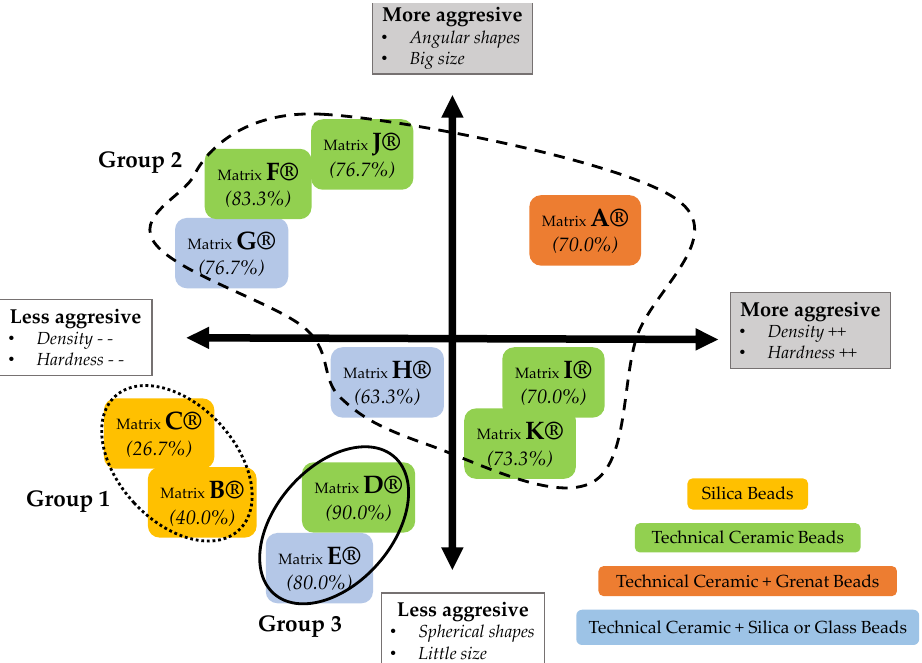
Figure 3. Repartition of the eleven mechanical lysing matrixes according to their characteristics and performances (percentage of detection at the concentration of 20